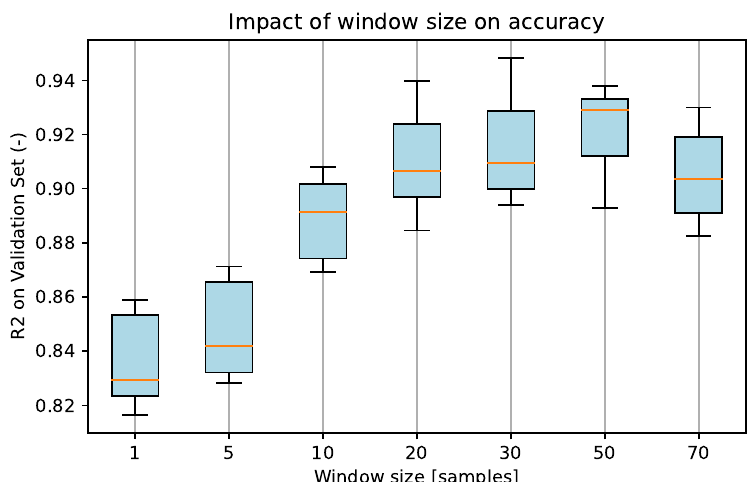
Figure 11. Effect of the Sliding Window size on R2